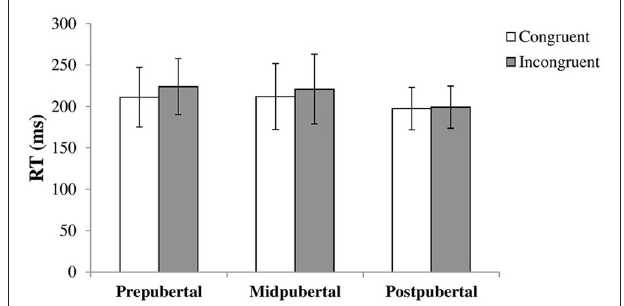
FIGURE 1 | Bars shown represent reaction times in ms, separate for congruent and incongruent trials, per pubertal group. Error bars show the standard deviation from the mean. Data showed a main effect for congruency with higher RTs for incongruent trials, and a main effect for pubertal status with lower overall RTs for the postpubertal group. There was no significant interaction